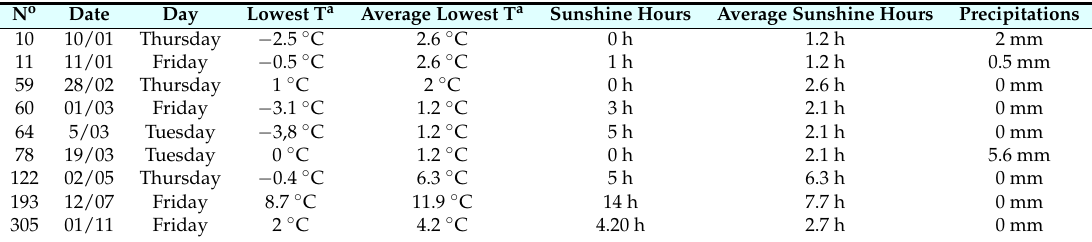
Table 2. Sample of other environmental characteristics from Dublin (temperature, sunshine and precipitation) which may impact hourly NO 2 concentrations measured at Blanchardstown air quality monitoring station. The averages shown represent the monthly average of each